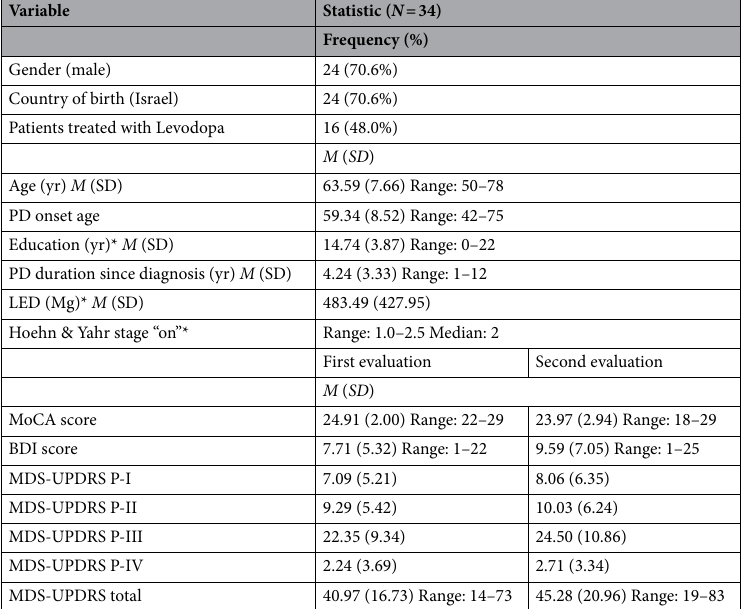
Table 1. Demographic and medical status characteristics of parkinson’s disease patients suspected for PD-MCI at the start and 1-year follow-up. LED, total daily Levodopa equivalent dose; Mg, milligrams; MoCA, Montreal Cognitive Assessment; BDI, Beck Depression Inventory 25 MDS-UPDRS P-I, nonmotor experiences of daily living; MDS-UPDRS P-II, motor experiences of daily living; MDS-UPDRS P-III, motor examination; MDS-UPDRS P-IV, motor complications 4 .